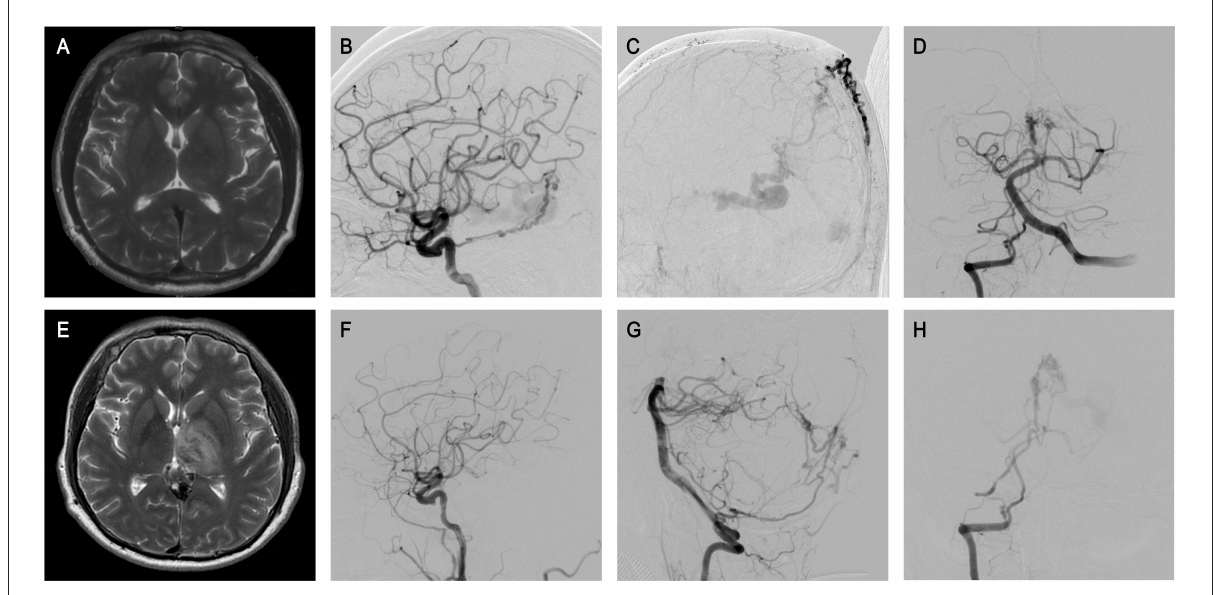
FIGURE2 The patient 33 presented that physical examination revealed intracranial vascular malformation for 3 months. (A) Preoperative MRI showed no obvious abnormalities. (B–D) ICA and VA, and ECA angiography revealed GDAVF feeded by the bilateral MMAs, OAs, MHTs, and right PMA, left IMA, left MPChA. (E) Half a month later, MRI sacan showed abnormal signals in bilateral thalamus area in T2, which was the manifestation of venous infarction. (F–H) Postoperative angiographic image. Postoperative angiogram images showing complete obliteration of the GDAVF (F, G) . Right VA arteriography suggested the intravenous outflow time of contrast agent was delayed (H) .